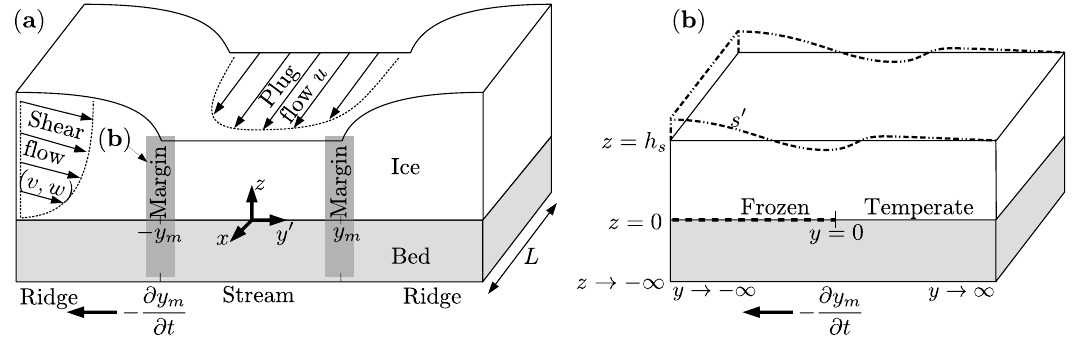
Figure 1. Panel (a) shows large-scale model geometry: we assume an ice stream flowing in positive x direction. At its sides, the ice stream is bordered by slowly moving ice ridges. Panel (b) shows boundary layer geometry, which moves at the rate v m = ∂y m /∂t through the ice stream/ridge geometry shown in panel (a)